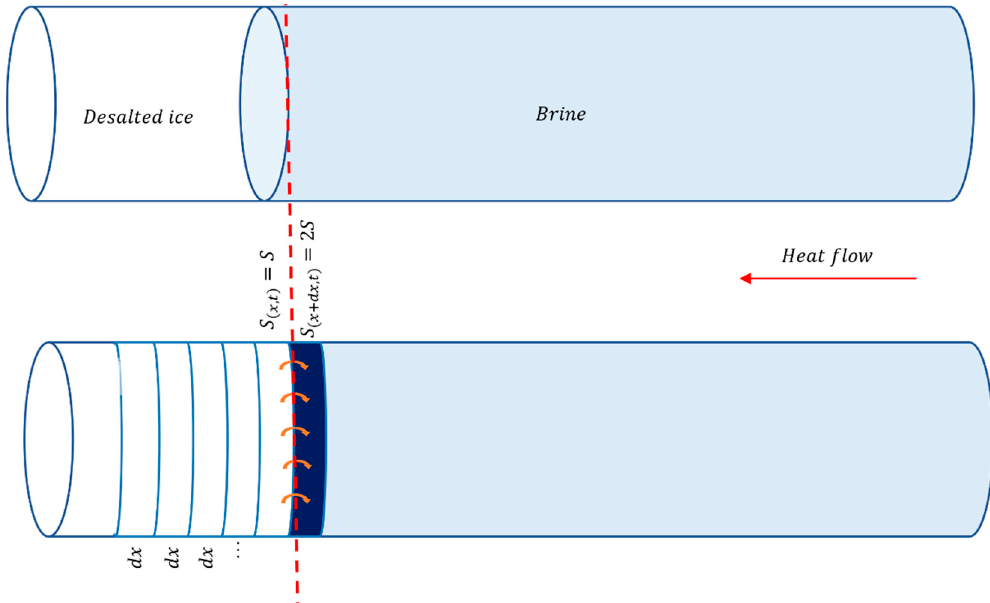
Figure 4. Thermal vs. mass diffusion competition and ion migration at the interface.